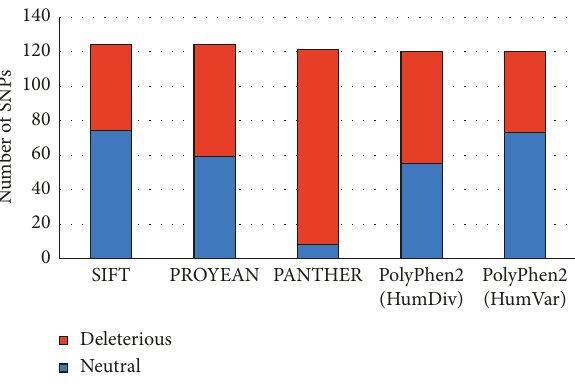
Figure 3: Deleterious SNPs of